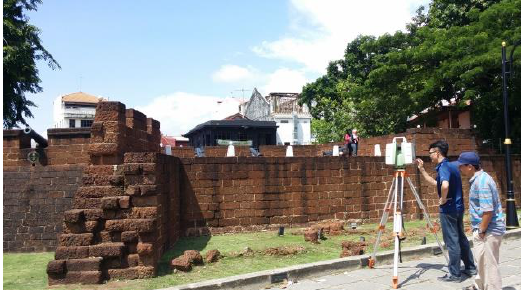
Figure 2. The scanning process from one of the scanning